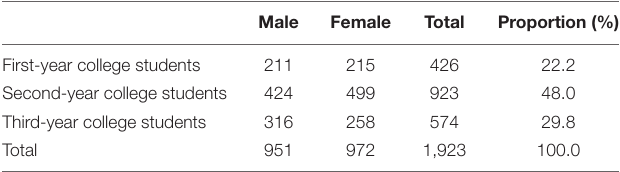
TABLE 1 | Characteristics of the study